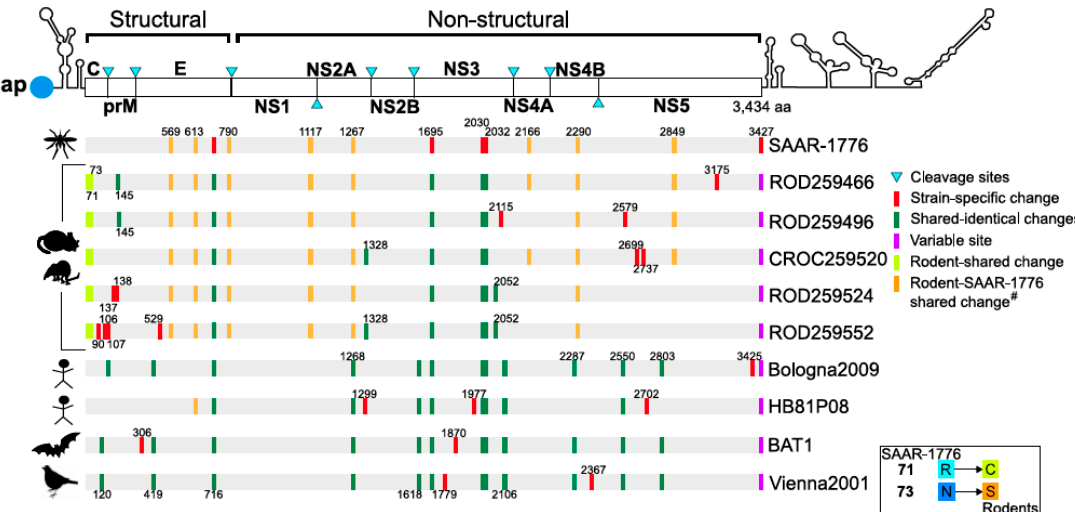
Figure 2. The comparative genome organization and mapping of amino acid differences between Usutu virus (USUV) sequences, characterized from different hosts. Positions are annotated and aligned to their loci in the USUV polyprotein. Host of origin and strain names can be found to the left and right of the polyprotein sequence maps, respectively. The shared non-synonymous changes from the SAAR-1776 to the rodent USUV strains are shown in the bottom right corner.